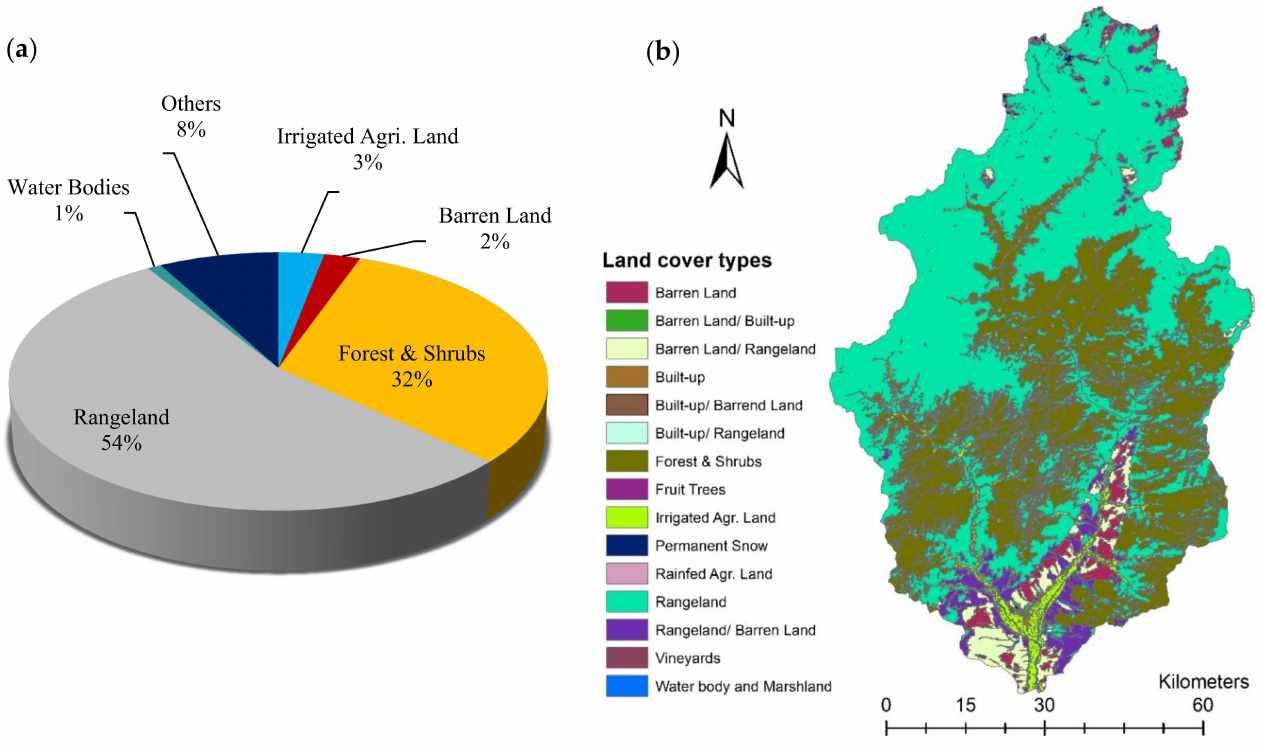
Figure 4. ( a ) Land use coverage (%) and ( b ) land use and land cover map of the study area. Source: The map and associated statistics have been derived from the Afghanistan land cover atlas [35].